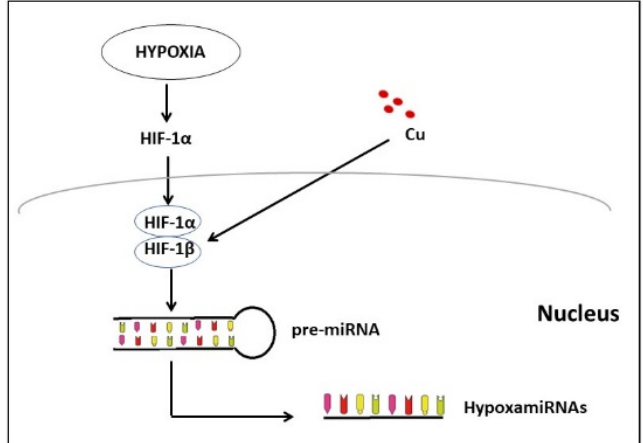
Figure 2. Hypoxia-induced miRNAs. Hypoxia-inducible factor 1 (HIF-1) mediates hypoxia response. The activation of many O 2 -regulated genes is mediated by HIF-1, a heterodimer consisting of HIF-1 α and HIF-1 β . HIF-1 α stimulates glycolytic gene expression in different types of cells and induces the angiogenesis process. Increased Cu levels induce stabilization of the HIF-1 α subunit, and HIF- 1 α binds HIF-1 β and forms a heterodimer that migrates into the nucleus, where transcription of hypoxia-related genes starts. In addition to the activation of gene transcription, the role of HIF-1 in pre-miRNAs and inducing the maturation of hypoxia-related miRNAs is also hypothesized. In addition to causing degradation or stabilization of the HIF- α and HIF- β heterodimer, hypoxia regulates the expression of approximately 50 specific miRNAs named